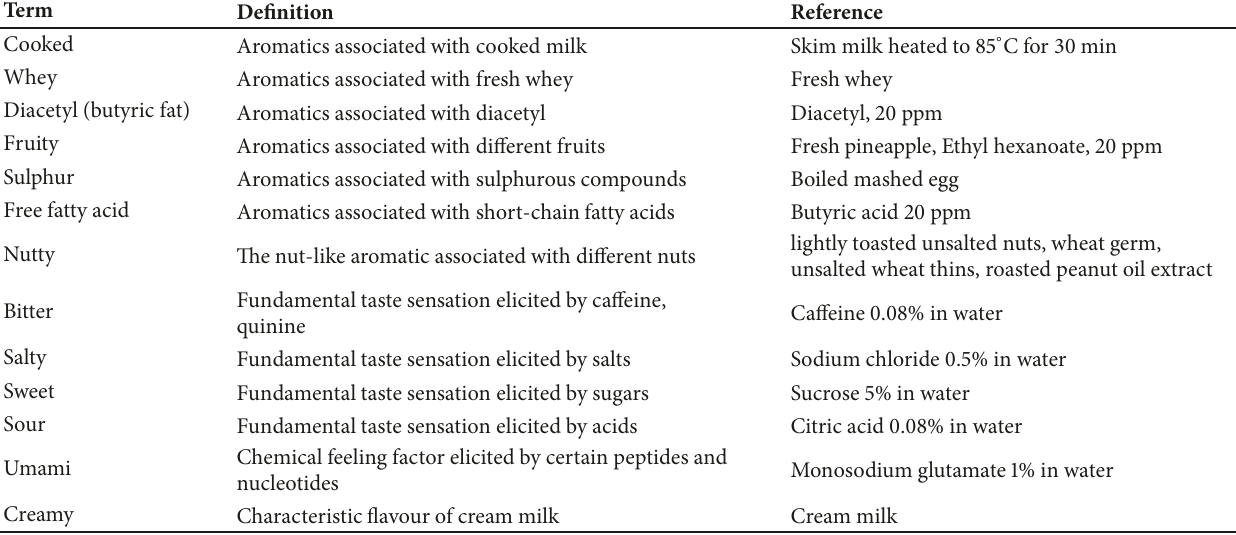
Table 1: Sensory evaluation terms used for evaluation of Chihuahua cheese [13,